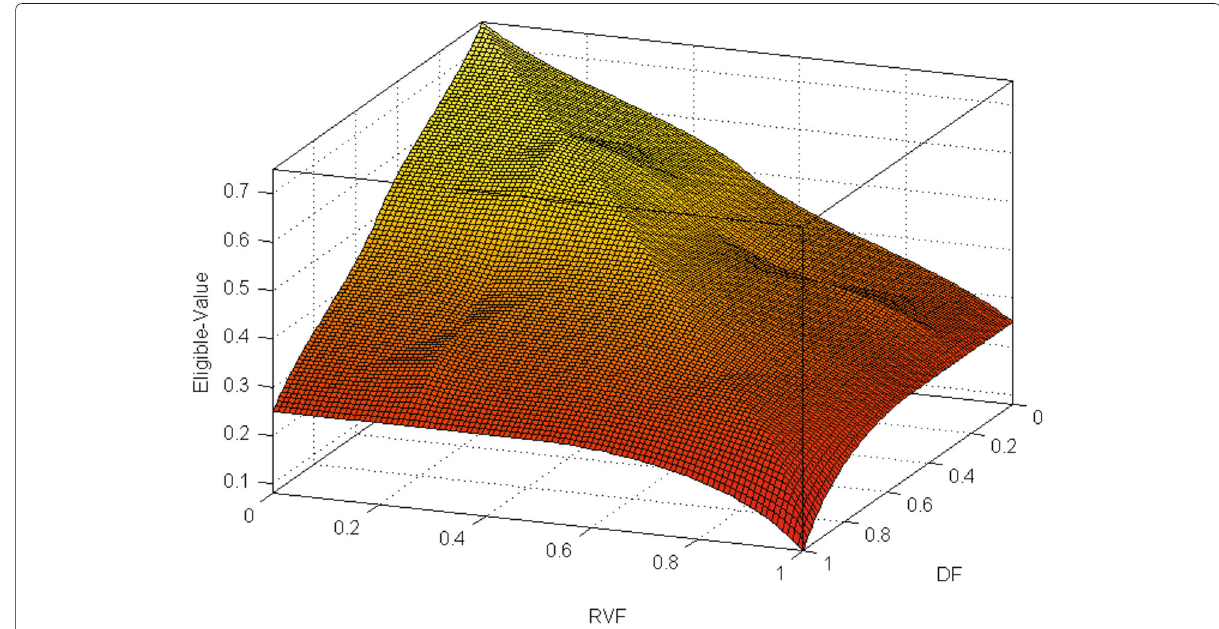
Fig. 13 Impact of DF and RVF on